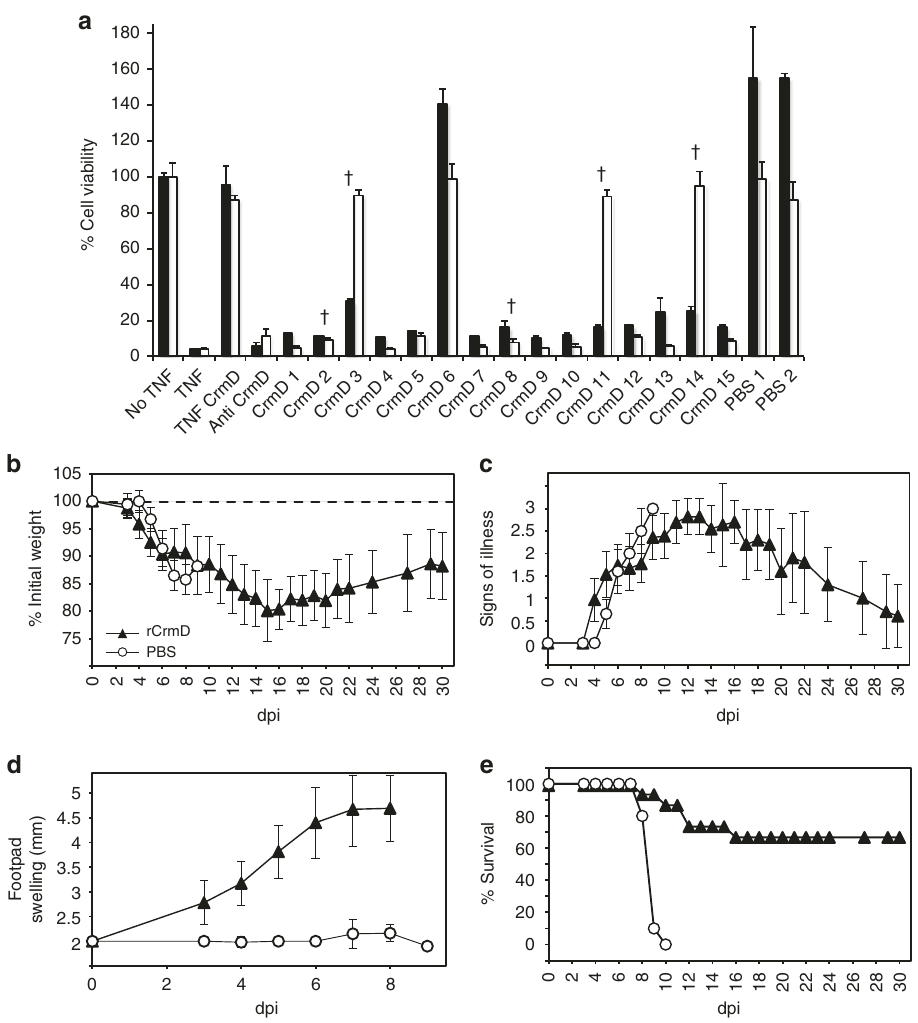
Fig. 9 Immunization with puri fi ed recombinant ECTV CrmD protects mice from fatal mousepox. Groups of BALB/c mice were immunized with PBS ( n = 10) (PBS, white circles) or recombinant ECTVCrmD protein ( n = 15) (rCrmD, black triangles), and challenged with 1000 PFU of ECTV per animal at 18 days after concluding the immunization procedure. a Neutralization of TNF activity in a TNF-induced cytotoxicity assay by serum from mice immunized with CrmD or PBS. L929 cells were incubated with TNF and CrmD in the presence of 1 µ l (white bars) or 2 µ l (black bars) of serum from mice immunized with CrmD (CrmD 1 – 15) or PBS (PBS 1 – 2). As controls, cell viability was determined in the absence of TNF (no TNF) or in the presence of TNF (TNF) incubated also with CrmD (TNF CrmD) or an antiserum against CrmD (anti CrmD). Mice that succumbed to infection are indicated with a cross. Data are mean + / − SEM of triplicate samples. b – e Mice infected with ECTV were monitored for weight loss ( b ), signs of illness ( c ), footpad swelling ( d ) and mortality ( e ) at the indicated times of infecion. Data are shown as mean + / −